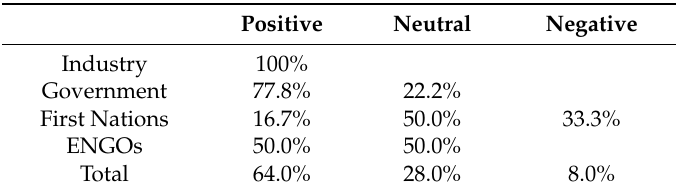
Table 2. Reported first impressions of MAS, represented as a proportion of members within a group and as a sample population total.